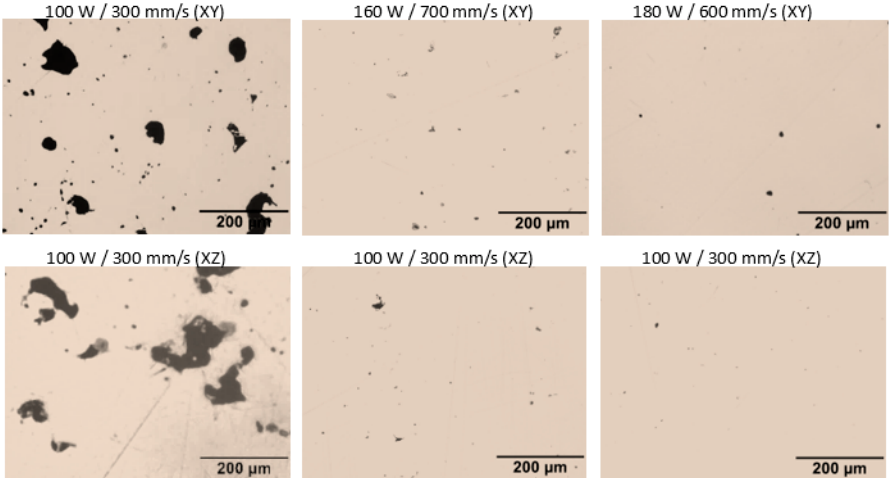
Figure 5. Optical images for selected process parameter combinations across (XY) and along (XZ) the building direction.